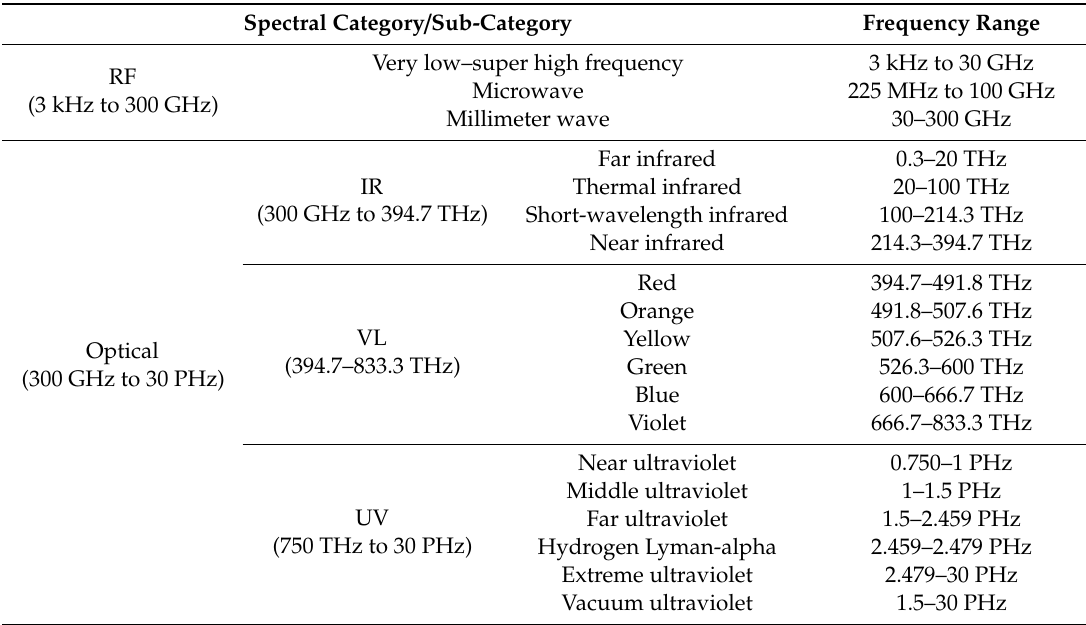
Table 3. RF and optical spectra